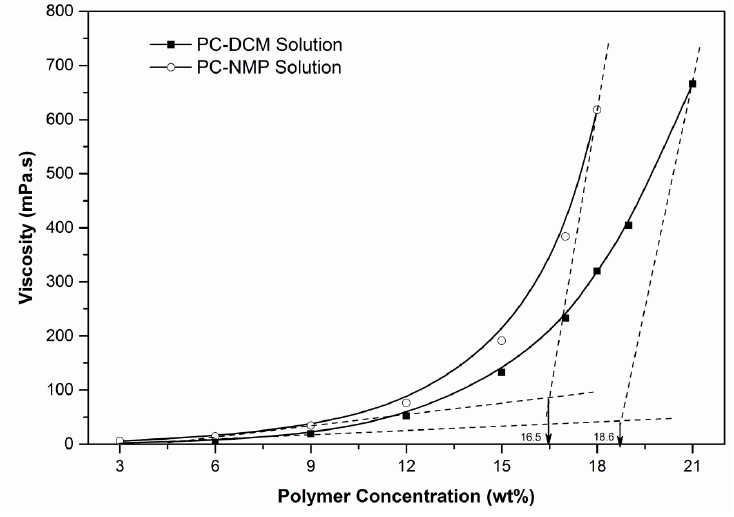
Figure 4. Critical polymer concentrations for PC-NMP and PC-DCM solutions. Table 2. Physical properties of PC-DCM and PC-NMP dope